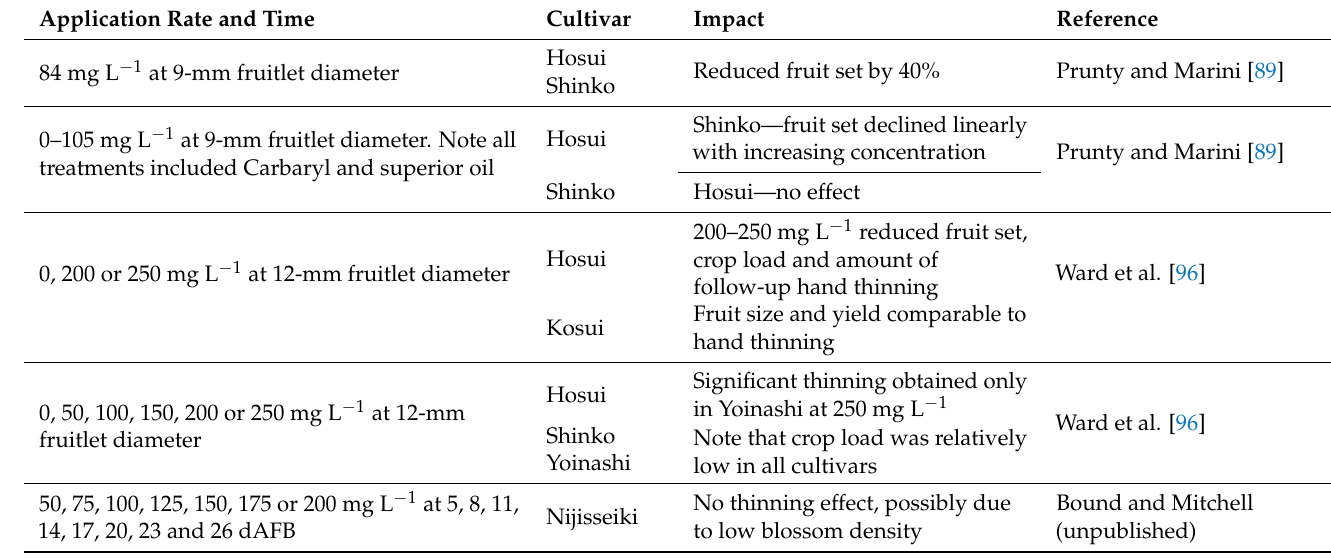
Table 11. Summary of the findings on the impact of 6-benzyladenine (BA) as a chemical thinning agent for nashi.